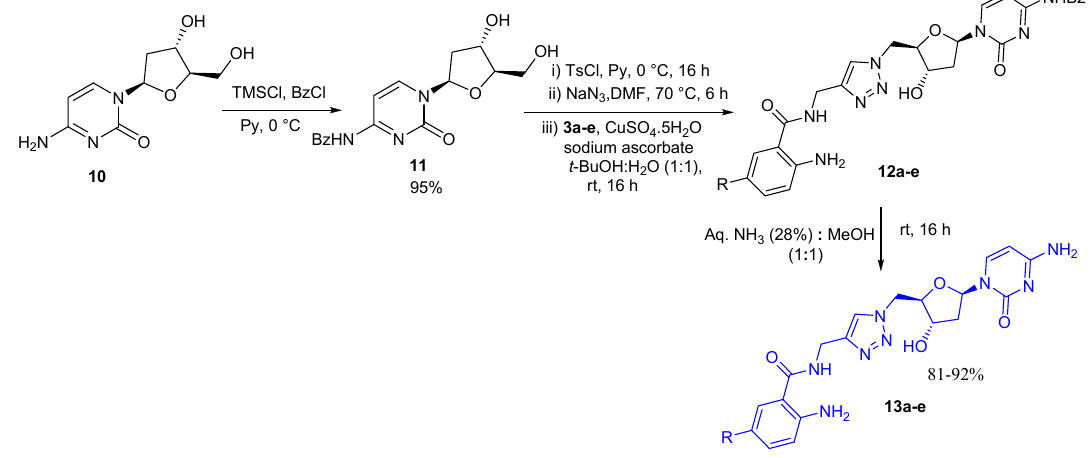
Scheme 5. Synthesis of 2 (cid:48) -deoxycytidine nucleotide analogues 13a–e